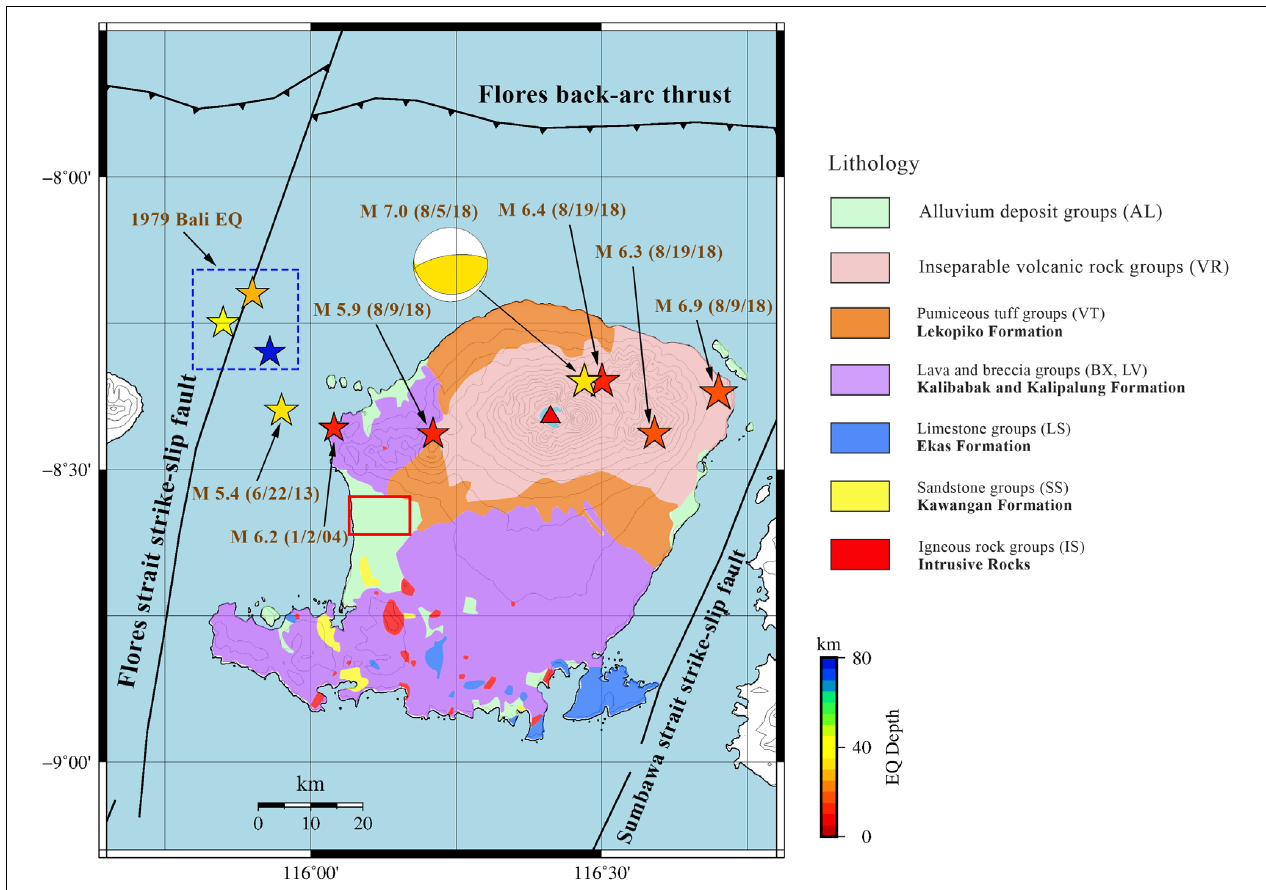
FIGURE 1 | Geological map of Lombok Island, Indonesia (modified from Mangga et al., 1994; Wafid et al., 2014); the study area is marked by a red square. The red triangle represents volcano in the region. The black lines represent active fault in the region obtained from Irsyam et al. (2017). The stars represent significant earthquakes that occurred from 1979 to 2018, obtained from Supartoyo et al. (2014) and Badan Meteorologi Klimatologi dan Geofisika (Badan Meteorologi Klimatologi dan Geofisika [BMKG], 2019) with the color of each star indicates the depth of the earthquake according to the color scale in the bottom right of the map. The focal mechanism of the 5th August 2018 earthquake is taken from Global CMT catalog (Dziewonski et al., 1981; Ekström et al.,